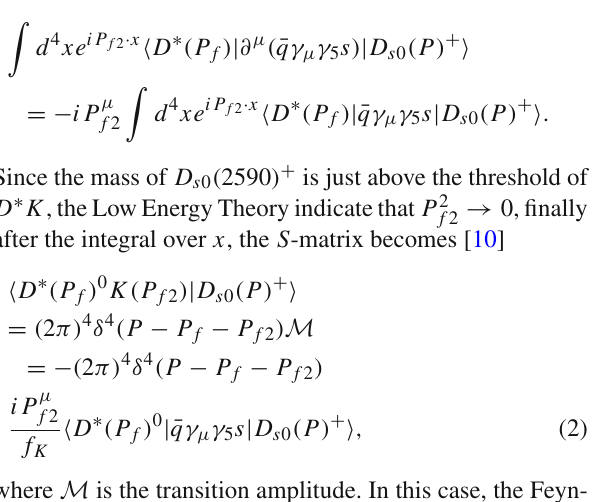
∂ μ ( ¯ q γ μ γ ) , where q = u , d for K + , K 0 , 1 5 s M 2 K f K